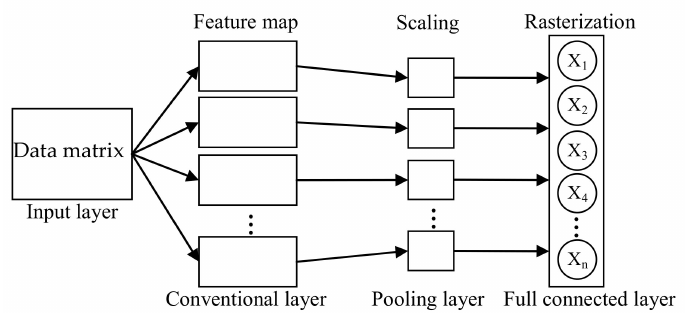
Figure 2. Infrastructure of a typical convolutional neural network